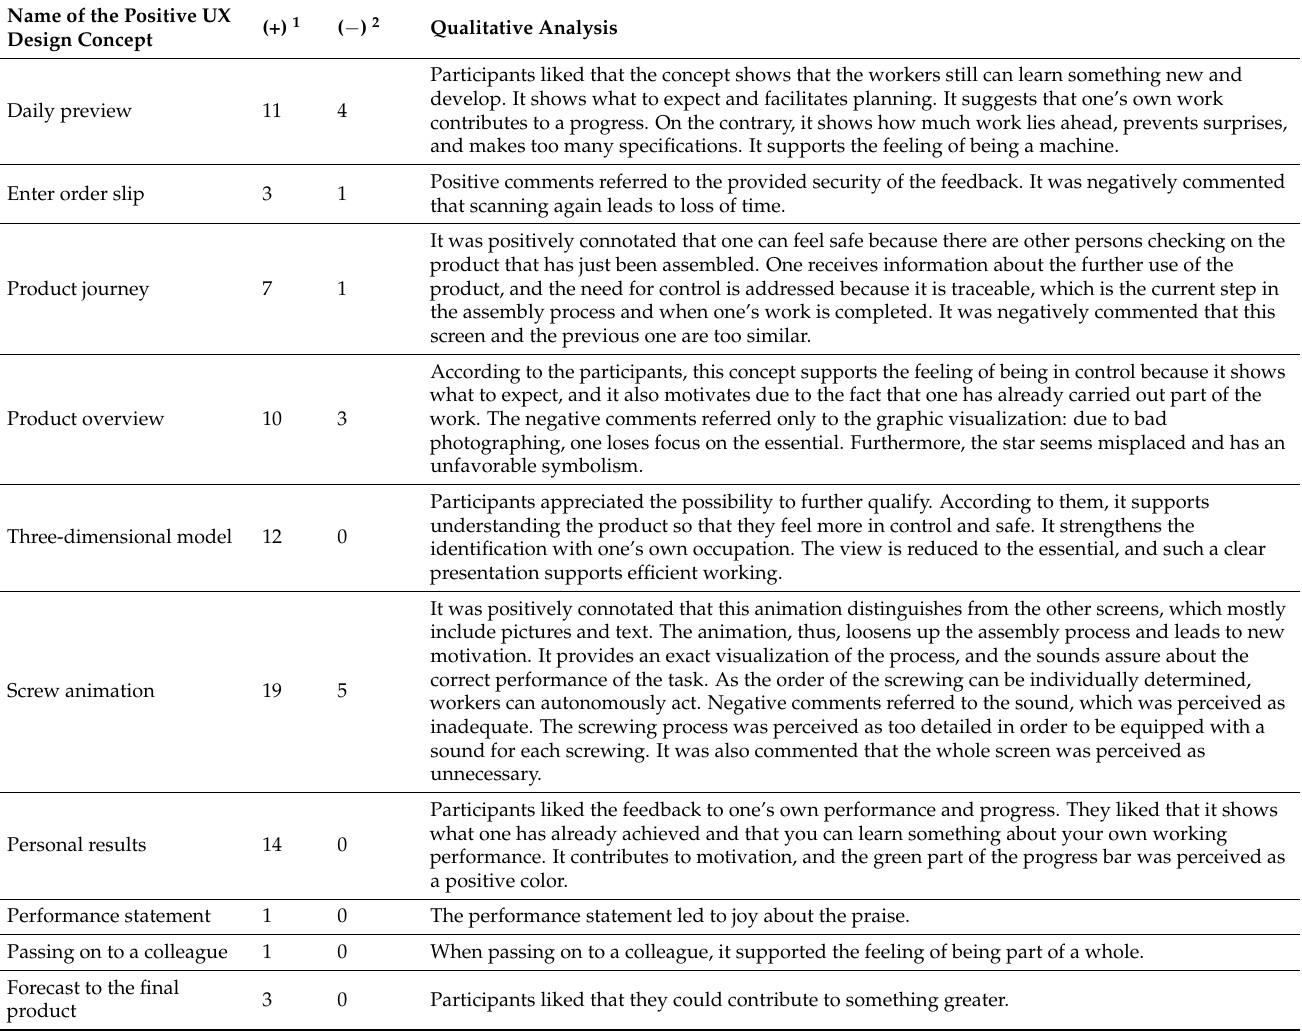
Table 3. Results of valence method for all positive user experience (UX) design